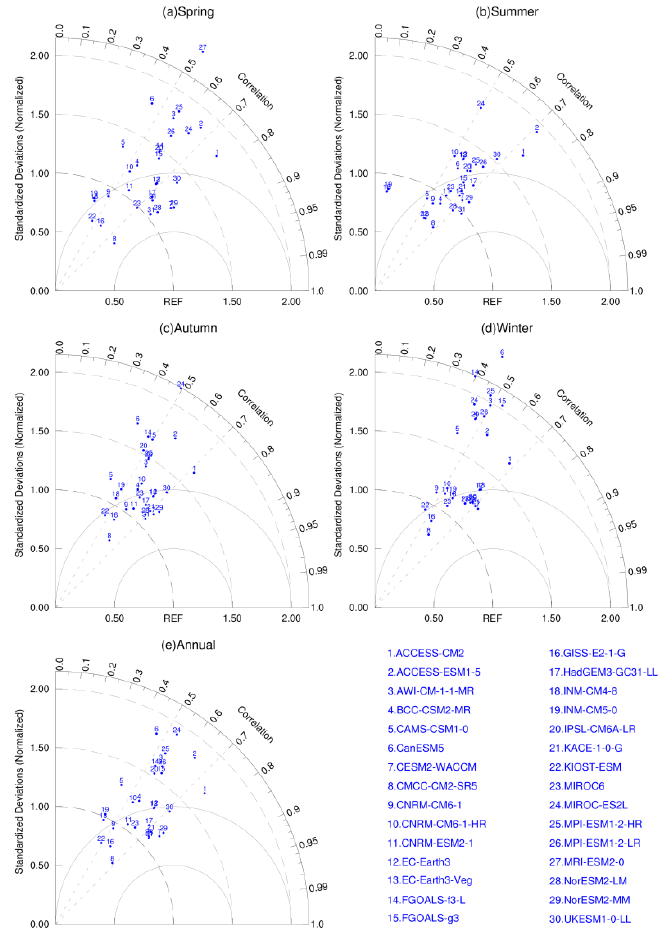
Figure 3. Taylor diagrams of ( a ) spring, ( b ) summer, ( c ) autumn, ( d ) winter, and ( e ) the annual mean for CMIP6 simulations in comparison with observations over China during 1975 – 2014. In the Taylor diagrams, angular axes show the spatial correlation coefficient (SCC) between the simulations and observations, radial axes show the spatial standard deviation (STD) normalized against that of the observations, and dashed arcs show the centered root mean square error (CRMSE). Numbers 1–31 represent the different CMIP6 models and AMME, and “REF” represents the observed NWS, which is at the intersection of the SCC of 1 and STD of 1. The closer the position is to REF, the better the performance of the model when not considering relative bias.